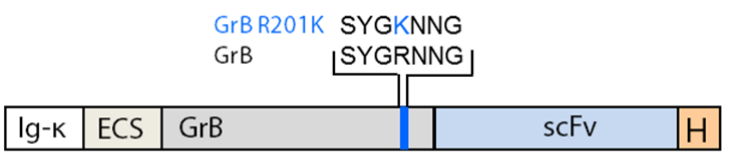
Figure 1. Schematic structure of granzyme B (GrB) -based cytolytic fusion protein (CFP) containing the R201K